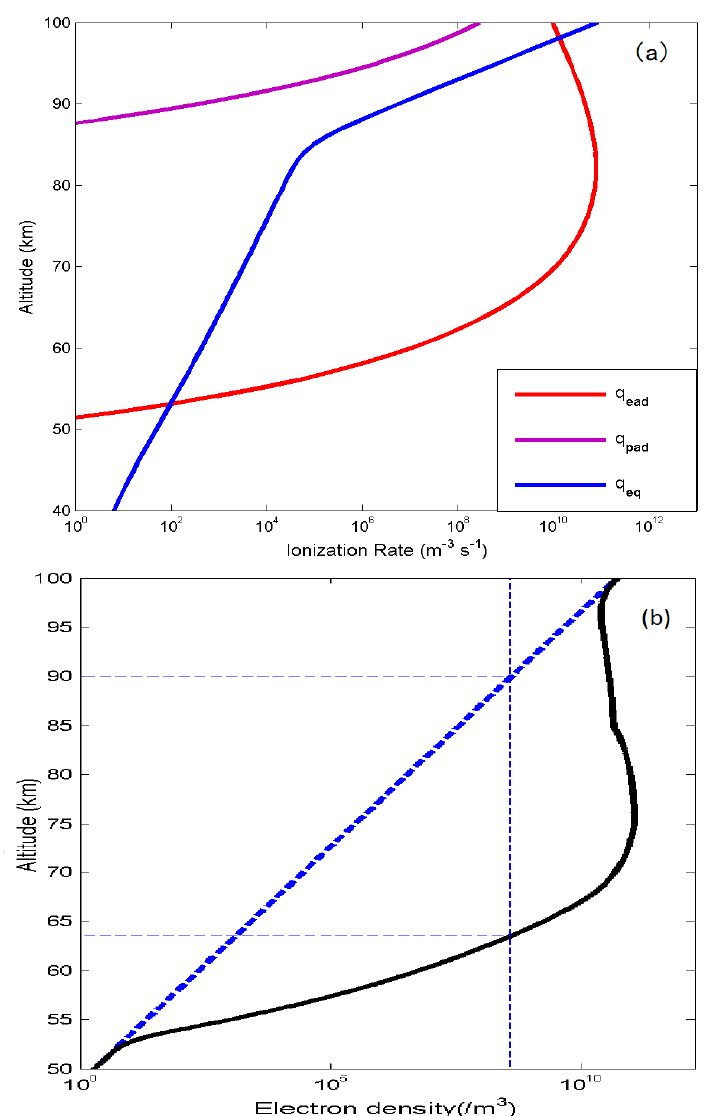
Figure 7. ( a ) Ionization rate profiles with altitudes in the state without precipitation is denoted by the blue line. The ionization rate profiles induced by precipitating energetic electrons and protons are denoted by the red line and pink line respectively. ( b ) The solid line shows the electron density profile due to energetic electron precipitation. The dashed line denotes the electron density profile without energetic electron precipitation.